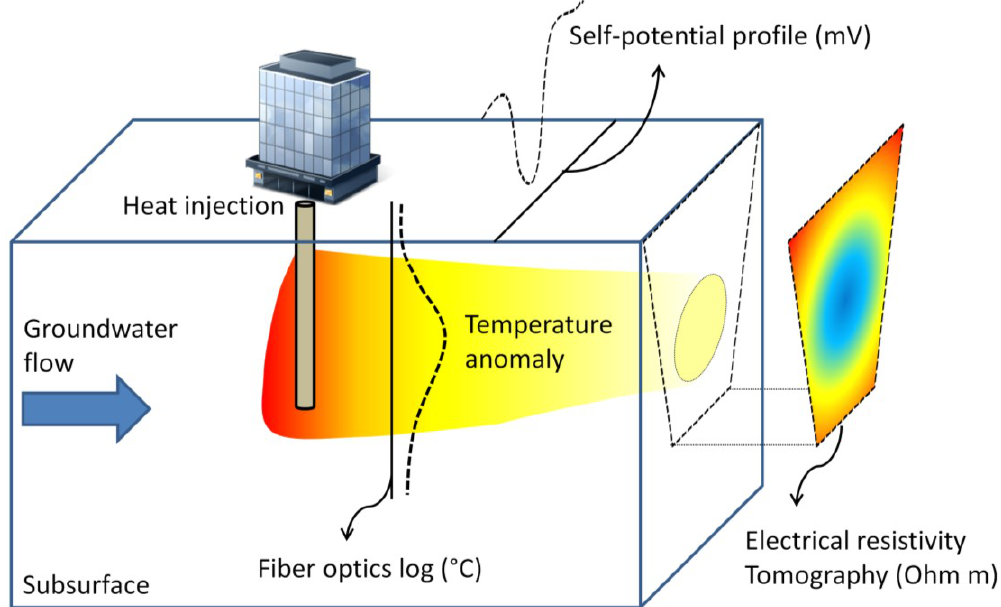
Figure 1. Emerging geophysical technologies to measure the temperature distribution in the subsurface due to heat injection in a fully non-invasive manner (electrical tomography and self-potential) to spatially continuous measures in boreholes (distributed fiber